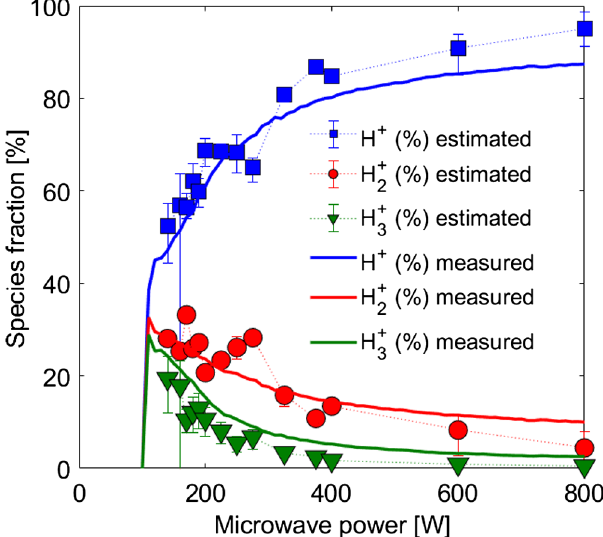
FIG. 7. Comparison between experimental values of the species fraction measured by Doppler-shift measurement unit and the values predicted by